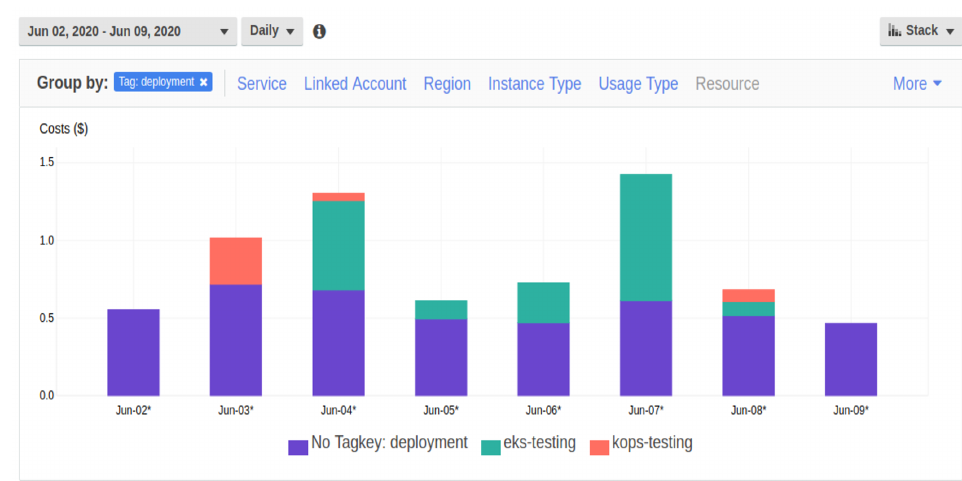
Figure 5. Cost report available on AWS Cost Explorer, grouped by the AWS tag: deployment .